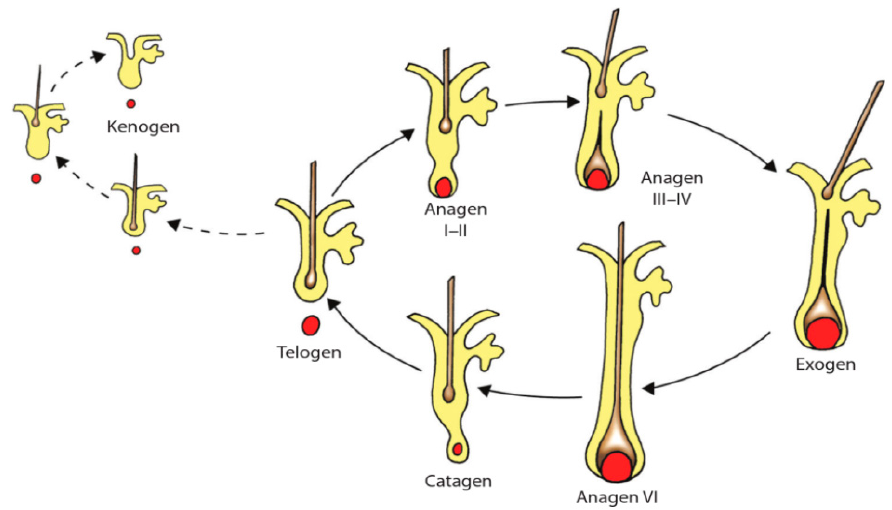
Figure 2. Hair life cycle. Reproduced with permission from [33], published by Springer Berlin Heidelberg, 2008.